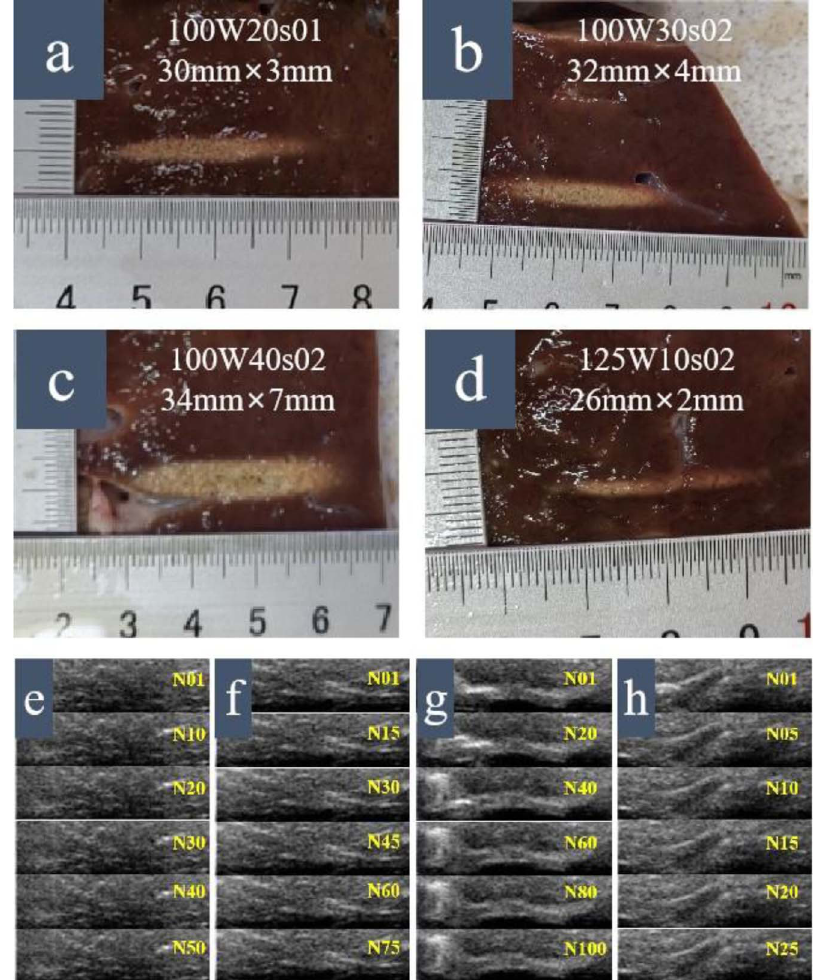
Figure 6. Thermal damage slices and B-ultrasound images (a) and (e) 100W20s, (b) and (f) 100W30s, (c) and (g) 100W40s, (d) and (h) 125W10s.